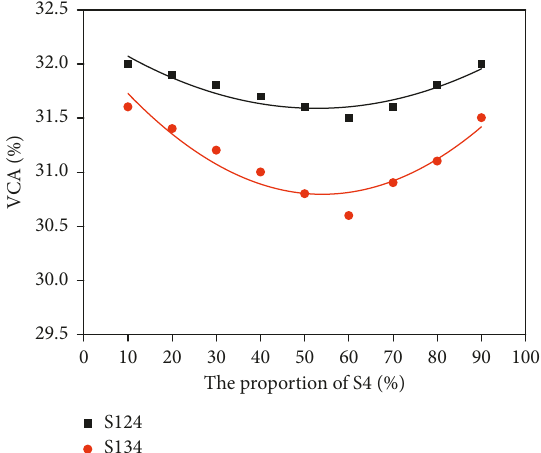
Figure 17: Influence of the content of secondary aggregates on the VCA.